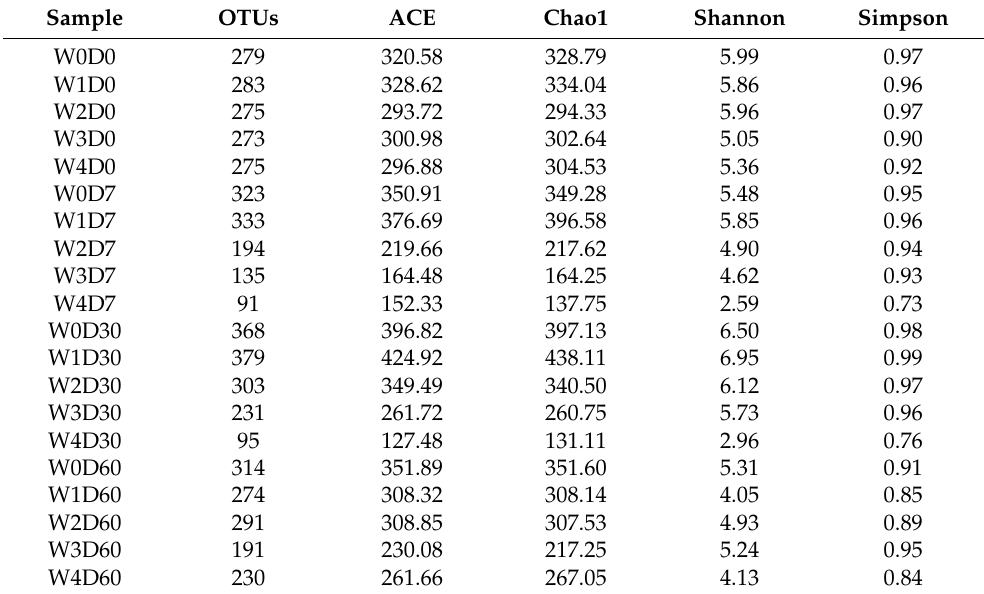
Table 1. Alpha diversity index of bacteria in water.